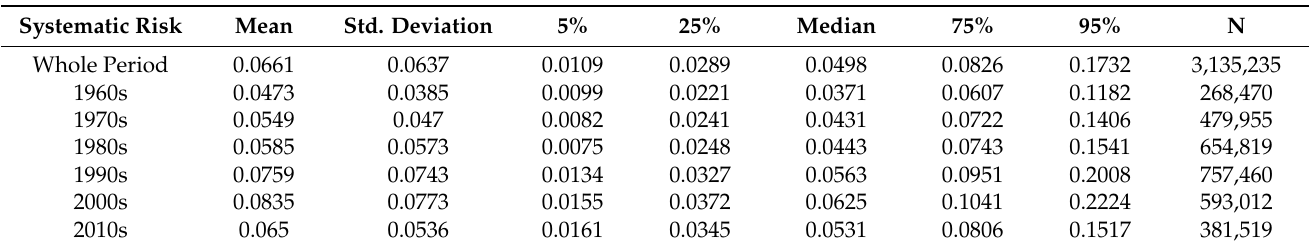
Table 1. Descriptive statistics of systematic risk. This table presents the descriptive statistics of systematic risk for individual stocks for the period of July 1963 to December 2019. The calculation of systematic risk is discussed in the context following Equation (1). For each month, a stock should have at least 15 days returns to be included in the calculation. Systematic